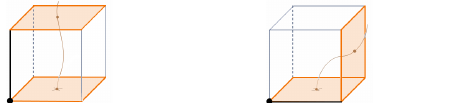
Figure 3. Depicted are two plaquettes that are related to the same lattice-point via parallel transport along the single edge depicted as a thicker black line. We distinguish two scenarios: ( left ) Two parallel pierced plaquettes correspond to a weakly curved flux-line. ( right ) Two orthogonal pierced plaquettes correspond to a strongly curved flux-line.